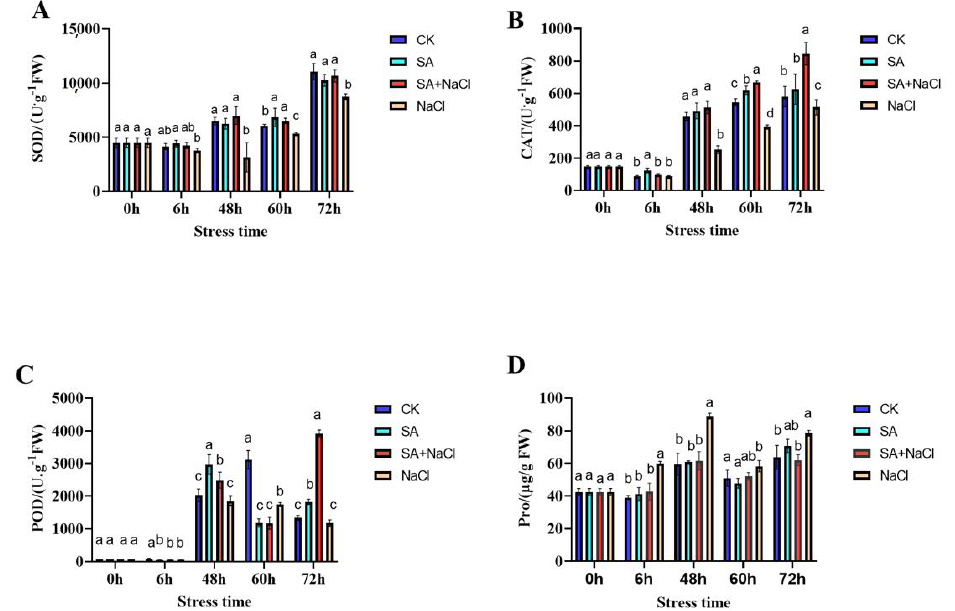
Figure 1. Effect of SA on physiological indicators of melon seeds under salt stress. ( A ) Superoxide dismutase activity (SOD); ( B ) catalase activity (CAT); ( C ) peroxidase activity (POD); ( D ) proline content (Pro). Different lowercase letters indicate significant differences at the 0.05 probability level ( p < 0.05) according to and Tukey’s multiple range tests.